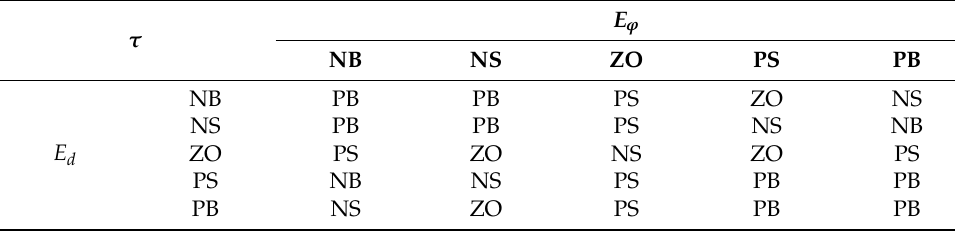
Table 1. Fuzzy rule of τ .